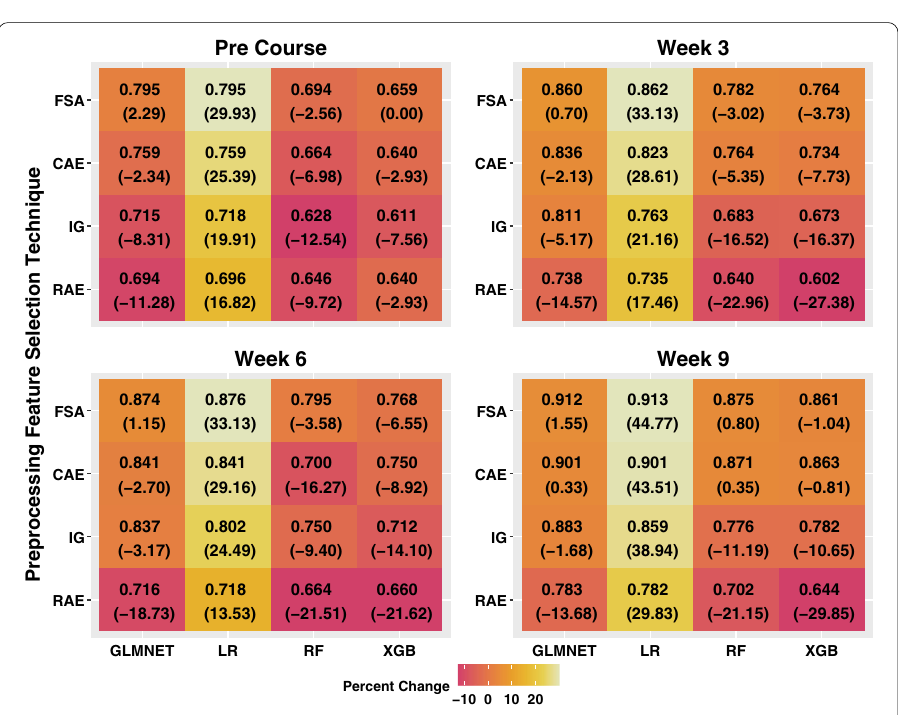
Fig. 6 Average percent difference between the AUC values obtained using and omitting feature selection. In each data table entry, the first number denotes the mean AUC, across all training and testing corpora, when preprocessing feature selection are applied, and six features are used as input to the DMM. The entries in parenthesis correspond to the mean percent difference in the AUC, denoted by the colored